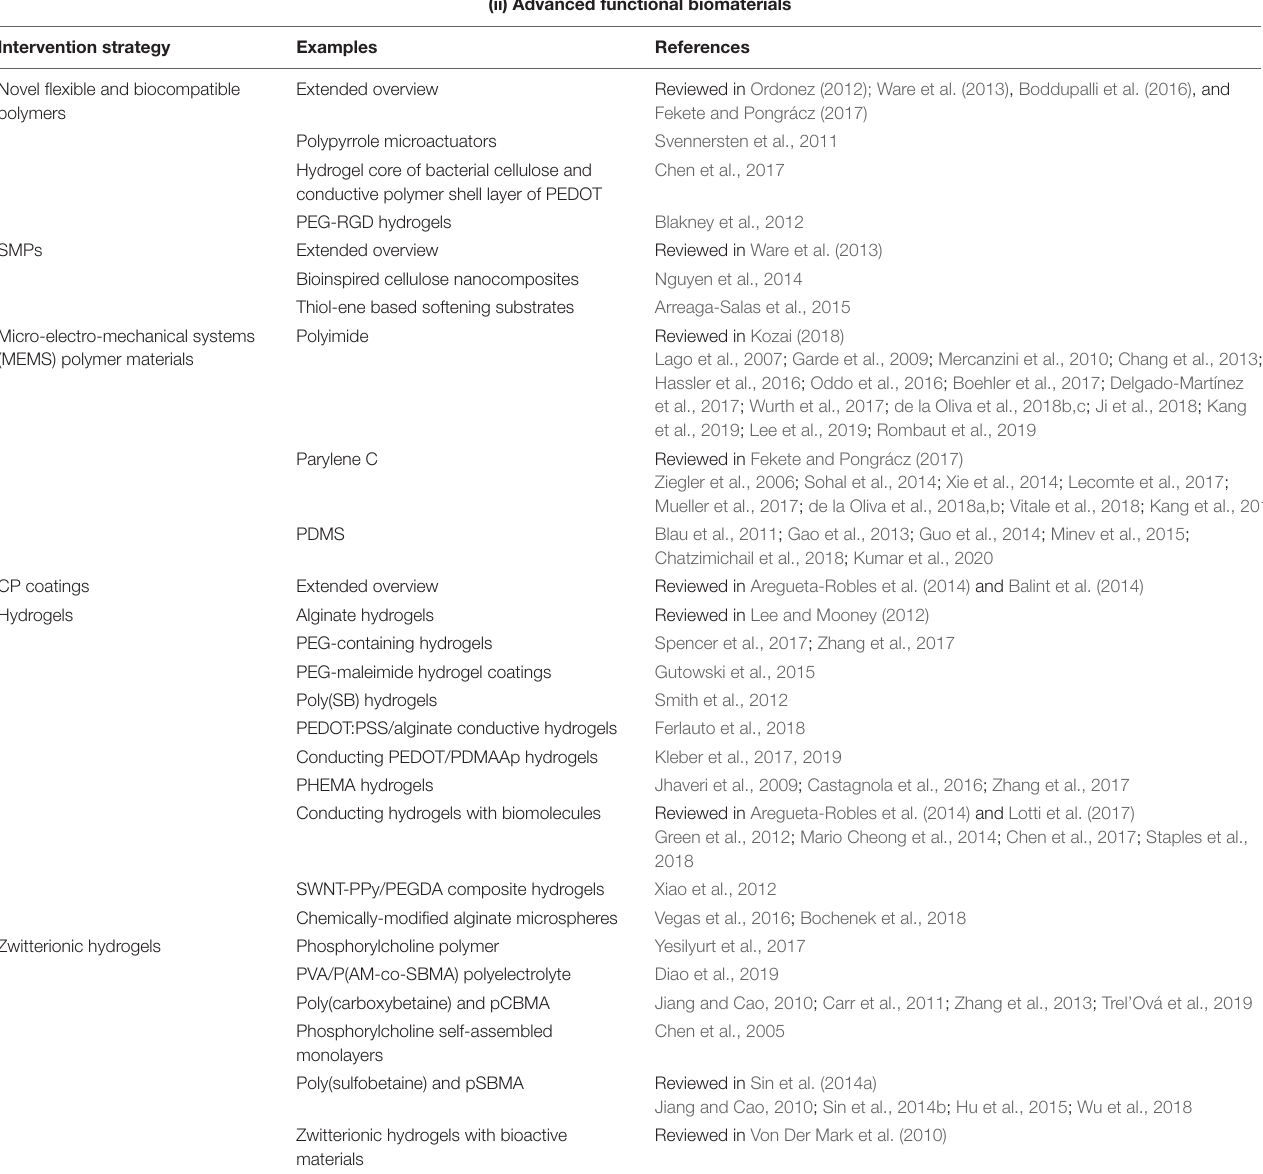
TABLE 2 | Intervention strategies based on the development of advanced functional biomaterials. (ii) Advanced functional